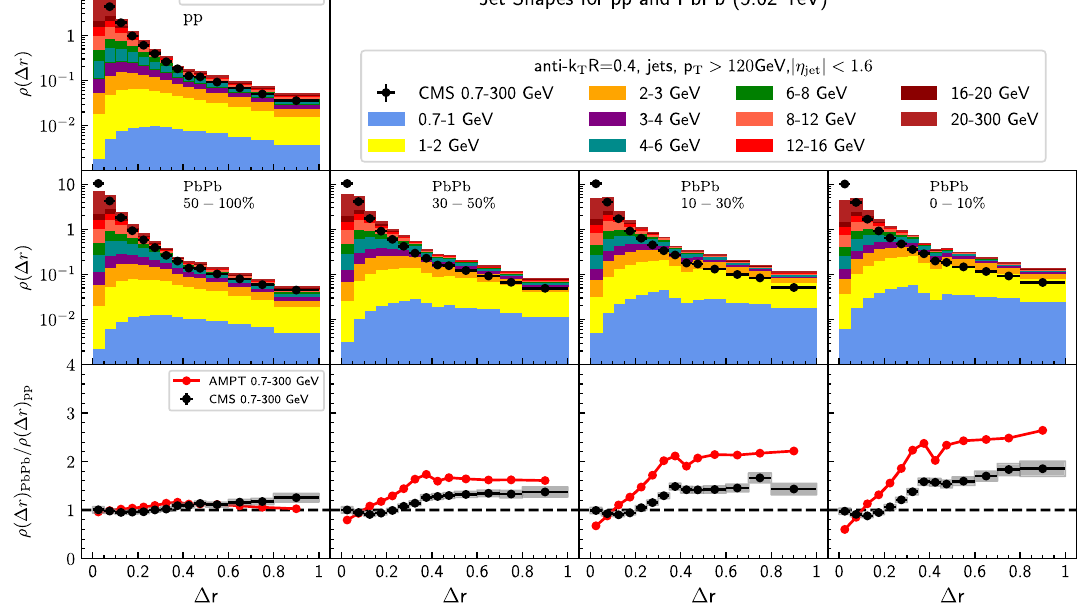
> 120 GeV, R = 0 . 4 Fig. 8 Jet shape ρ((cid:2) r ) for jets with p jet tributionsfromdifferent p T intervalsforchargedparticles.Theaccumu- T and | η jet | < 1 . 6 in p + p (top left panel) and Pb + Pb (middle pan- lated histogram is for 0 . 7 < p T < 300 GeV. The bottom panels show els) collisions. Four different Pb + Pb collision centralities are shown: the ratio between Pb + Pb and p + p collisions for p T = 0 . 7 − 300 GeV. 0 − 10% , 10 − 30% , 30 − 50%, and 50 − 100%. The stacked histograms The data are taken from CMS are obtained from the AMPT model: different colors represent the con-